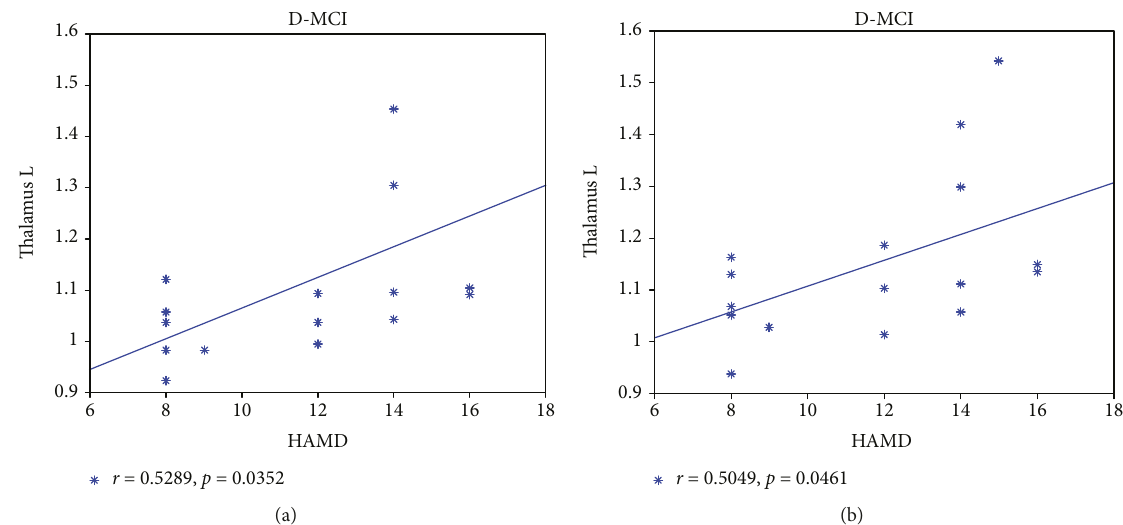
Figure 3: Correlation analysis between the abnormal CReHo values and HAMD scores in D-MCI patients, including the left thalamus in the typical frequency band (a) and the left thalamus in the slow-4 frequency band (b). D-MCI: mild cognitive impairment with